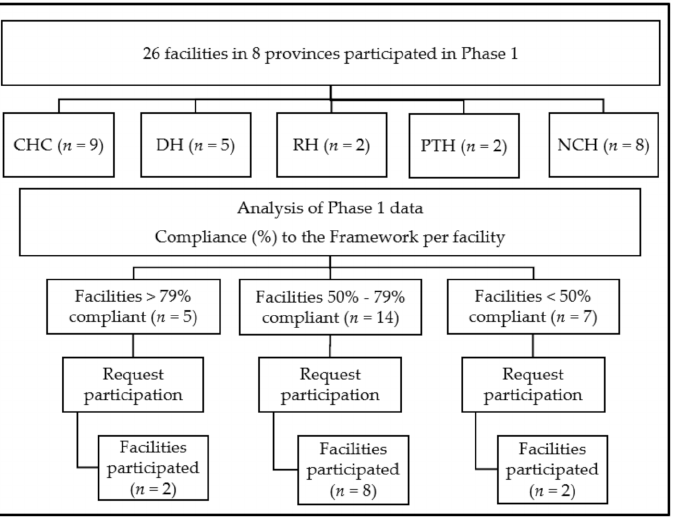
Figure 2. Study sites for Phase 1 [33] and Phase 2. CHC = Community Health Centre; DH = District Hospital; RH = Regional Hospital; PTH = Provincial Tertiary Hospital; NCH = National Central